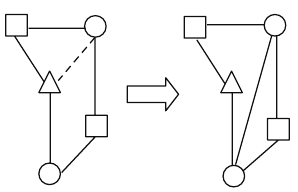
Figure 1: Things of one kind come together.